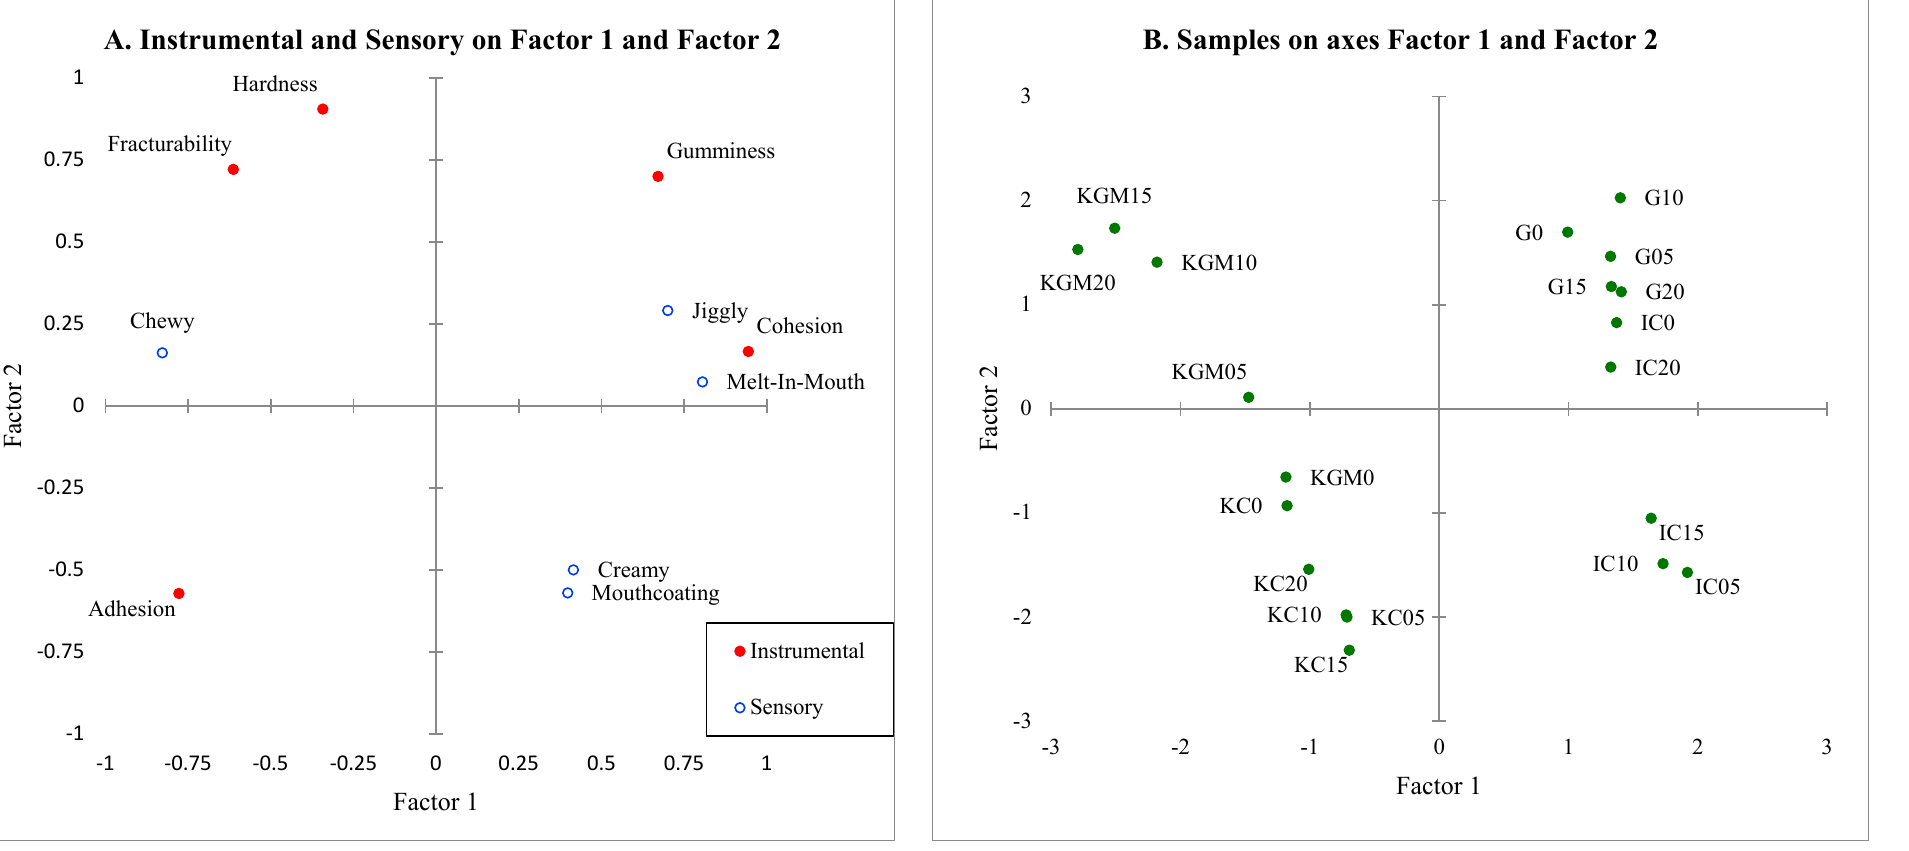
Figure 6. Partial least squares regression biplot for Factors 1 and 2 for Instrumental Parameters (x-variable) and Sensory Texture Attributes (y-variable) on 20 model confectionary gels: ( A ) correlations on Factor 1 and Factor 2; ( B ) observations on axes Factors 1 and 2. G = gelatin, IC = ι -carrageenan, KC = κ -carrageenan, KGM = konjac glucomannan.